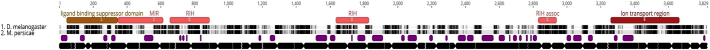
Alignment of D. melanogaster IP3R with M. persicae IP3R. Black arrows indicate individual exons. The approximate location of additional amino acids found in the aphid channel are indicated in purple. There are 36 individual insertions in the aphid channel with the largest being 63 amino acids in length. IP3R functional domains are mapped on the D. melanogaster sequence. (For interpretation of the references to colour in this figure legend, the reader is referred to the web version of this article.)